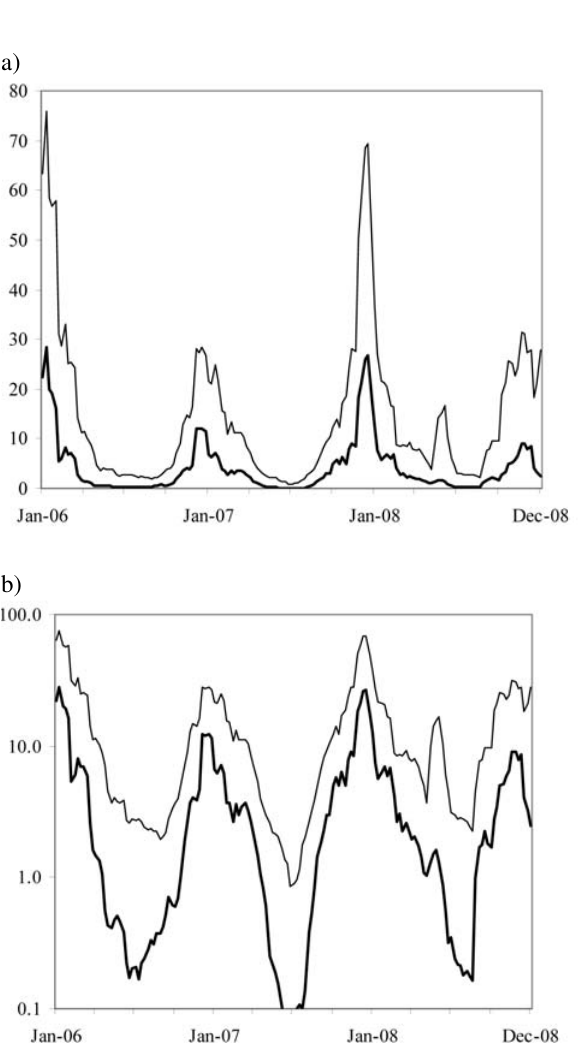
Fig. 1. 2006–2008 time series of total (sum of gas and particulate phases; thin line) and particulate phase (bold line) PAH concentra- tion in air (ng m –3 ) in Ko{etice, Czech Republic, plotted (a.) li- nearly and (b.) logarithmically. Sum of 15 species (i.e. 16 USEPA priority PAHs without NAP), gliding monthly mean of weekly 24h- samples.